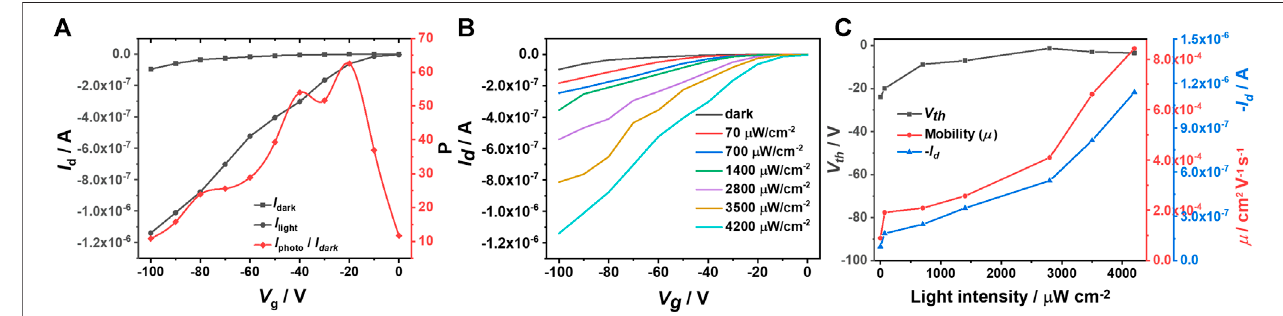
FIGURE 2 | (A) Transfer curves of (IDTOT-4F) based optoelectrical devices in the dark and under illumination, and the corresponding P values vs. V g ; (B) Transfer curves of optoelectrical devices at different light intensities with a constant pulse with of 10 sec; (C) Source-drain currents, threshold voltages ( V th ) and mobilities ( μ ) vs. light intensities. The V d values for the above measurements are set as − 100